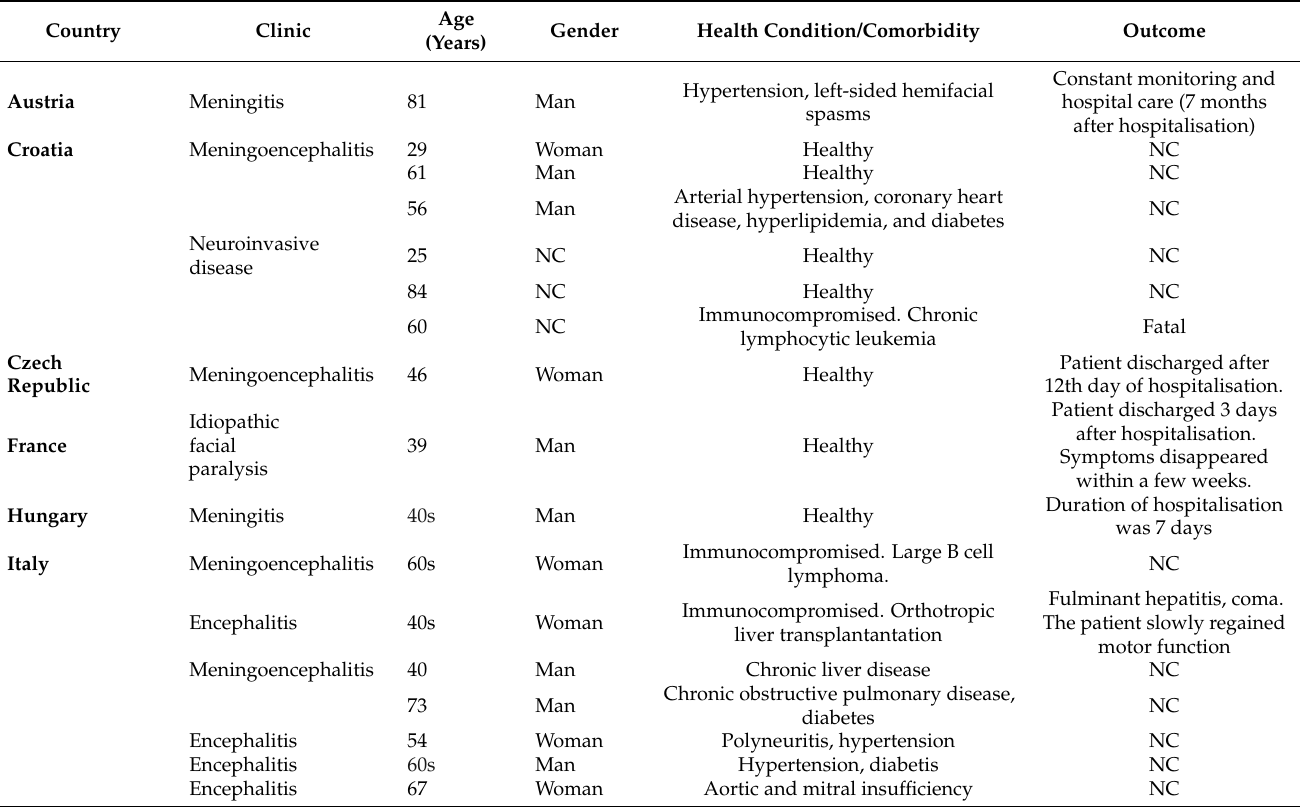
Table 3. Description of clinical case with identified neurological damage. NC: Not